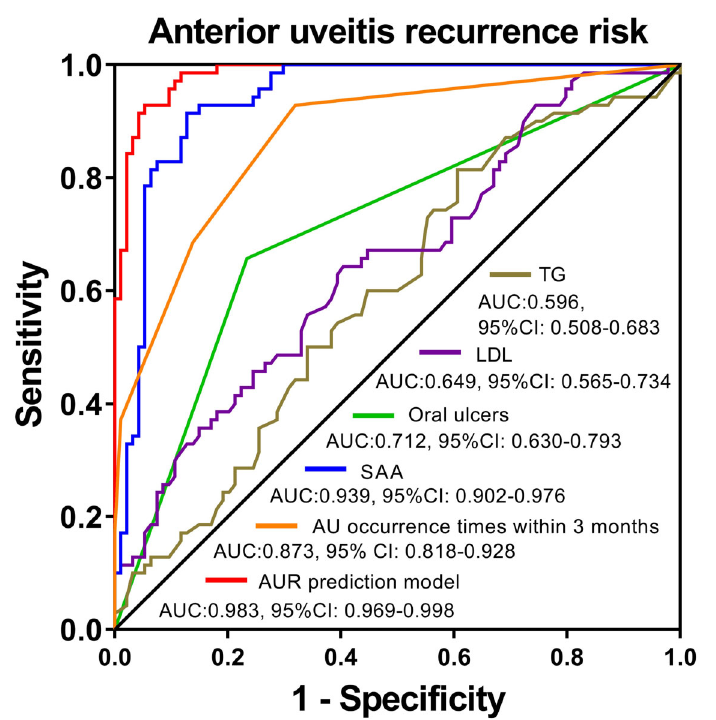
Figure 1. Predictive value of factors for UR risk in Behcet ’ s disease patients. The ROC curves and the derived AUC were used for assessment of the predictive performance of factors. ROC: receiver operating characteristic; UR: uveitis recurrence; AUC: area under the curve; TG: triglycerides; LDL: low-density lipoprotein; SAA: serum amyloid A. UR prediction model where -2ln(LR)=52.680: e ½ 1 : 415 ð uveitisoccurrencetimeswithin3months Þþ 2 : 273 ð Oralulcers Þþ 3 : 111 ð TG Þþ 1 : 839 ð LDL Þþ 0 : 342 ð SAA Þ(cid:2) 24 : 188 P ¼